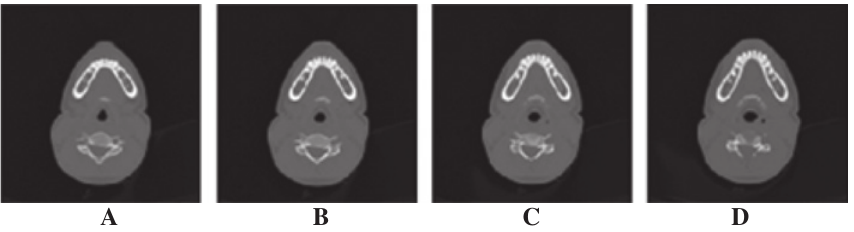
Figure 2: Axial cross section of a human head CT-(A–D) corresponds to the first four slices respectively in DICOM